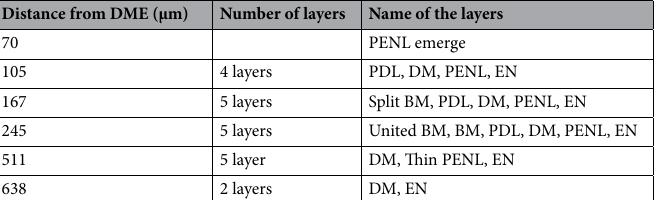
Table 1. The number and name of the Layers present at a distance from the DME at the posterior pre-limbal cornea.